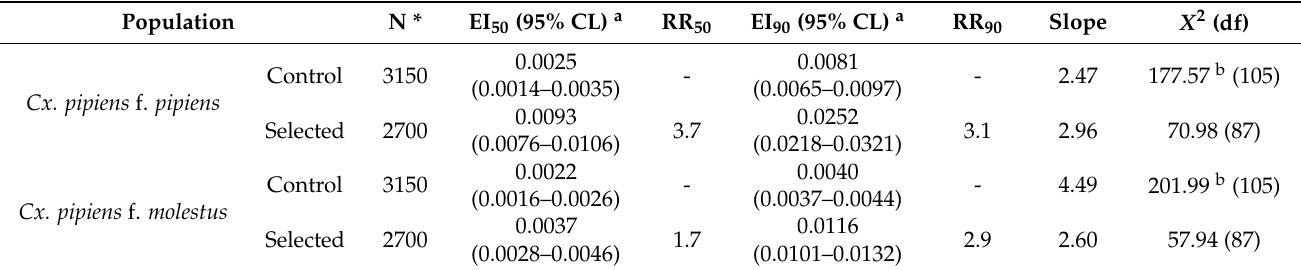
Table 1. Effective doses of diflubenzuron against the two forms of Culex pipiens after the selection process for three successive generations by applying fixed doses corresponding to EI 80 of the control populations. Population